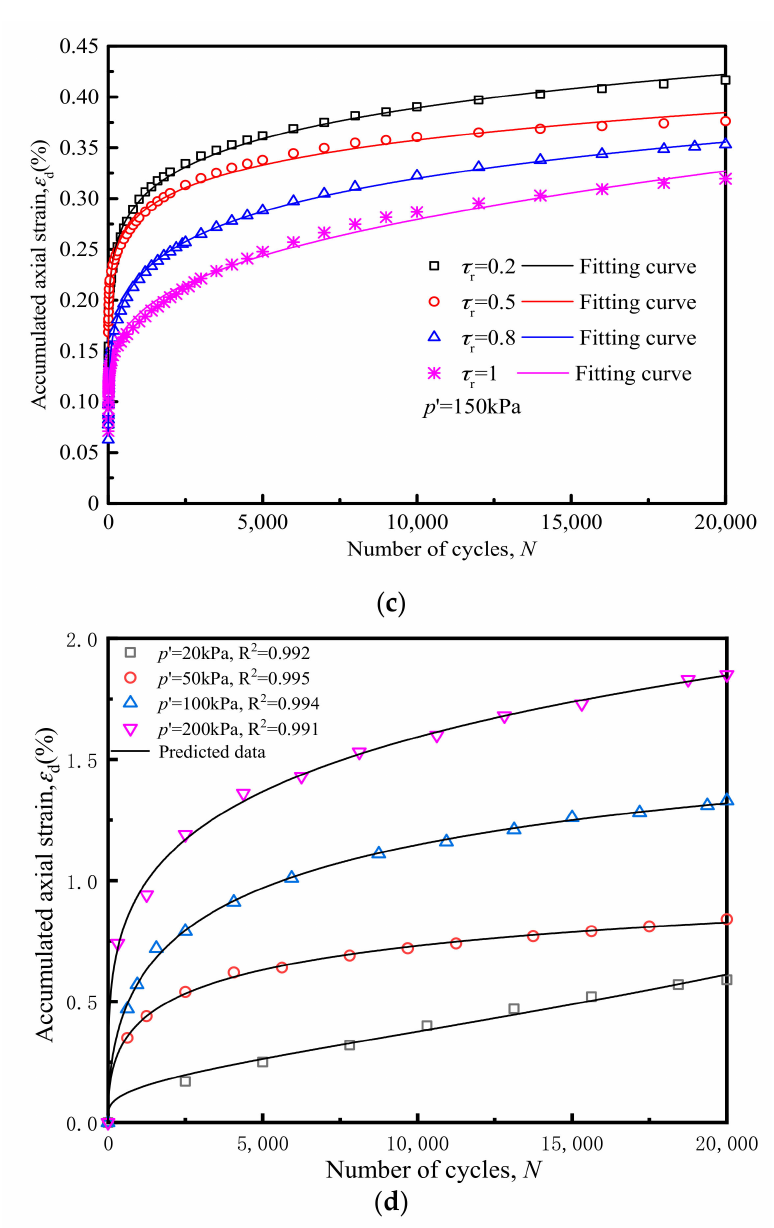
Figure 20. Comparison between measured and predicted results of tests, ( a ) p (cid:48) = 250 kPa, ( b ) p (cid:48) = 200 kPa, ( c ) p (cid:48) = 150 kPa, ( d ) Guo lin’s